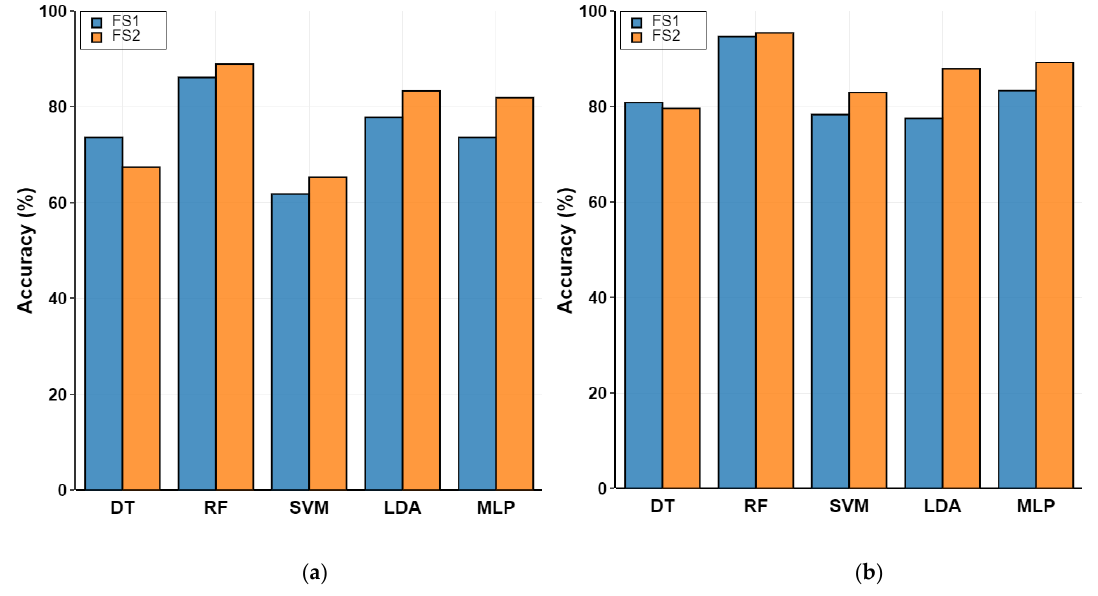
Figure 4. Classification results of classifiers depending on the two feature sets (FS1 and FS2) with the datasets prepared by applying the two different segment approaches: ( a ) DS1 and ( b ) DS2.